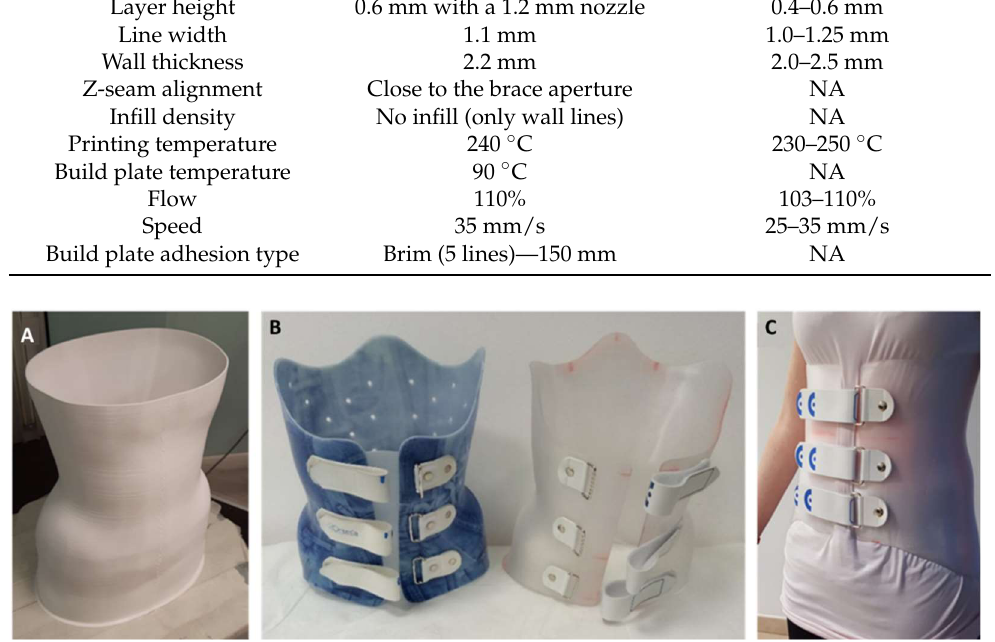
Figure 5. Three-dimensional printed orthosis production: ( A ) orthosis on the build plate before post- processing, ( B ) 3D-printed orthosis (right) compared with thermoformed orthosis (left), and ( C ) 3D- printed orthosis worn by the